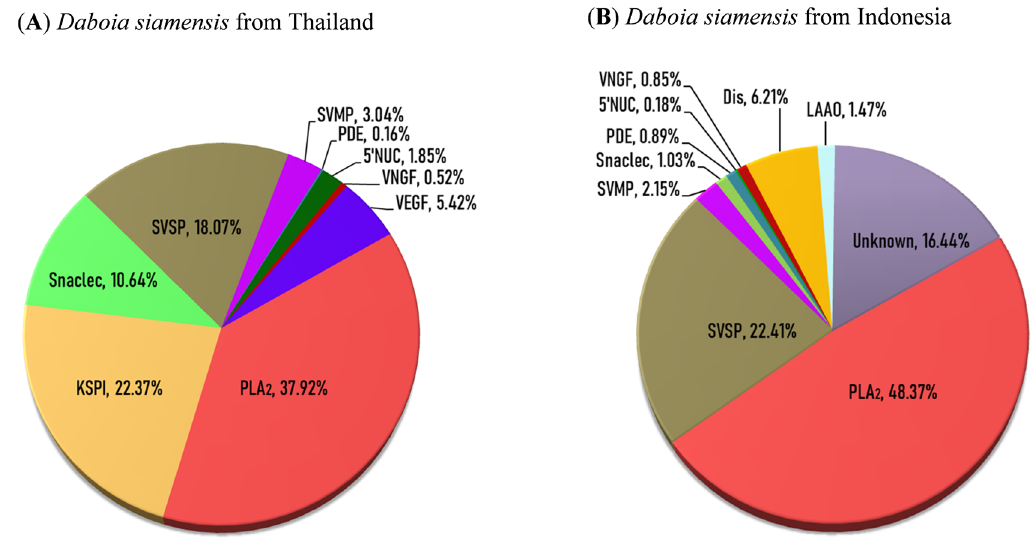
: phospholipase A ; 2 2